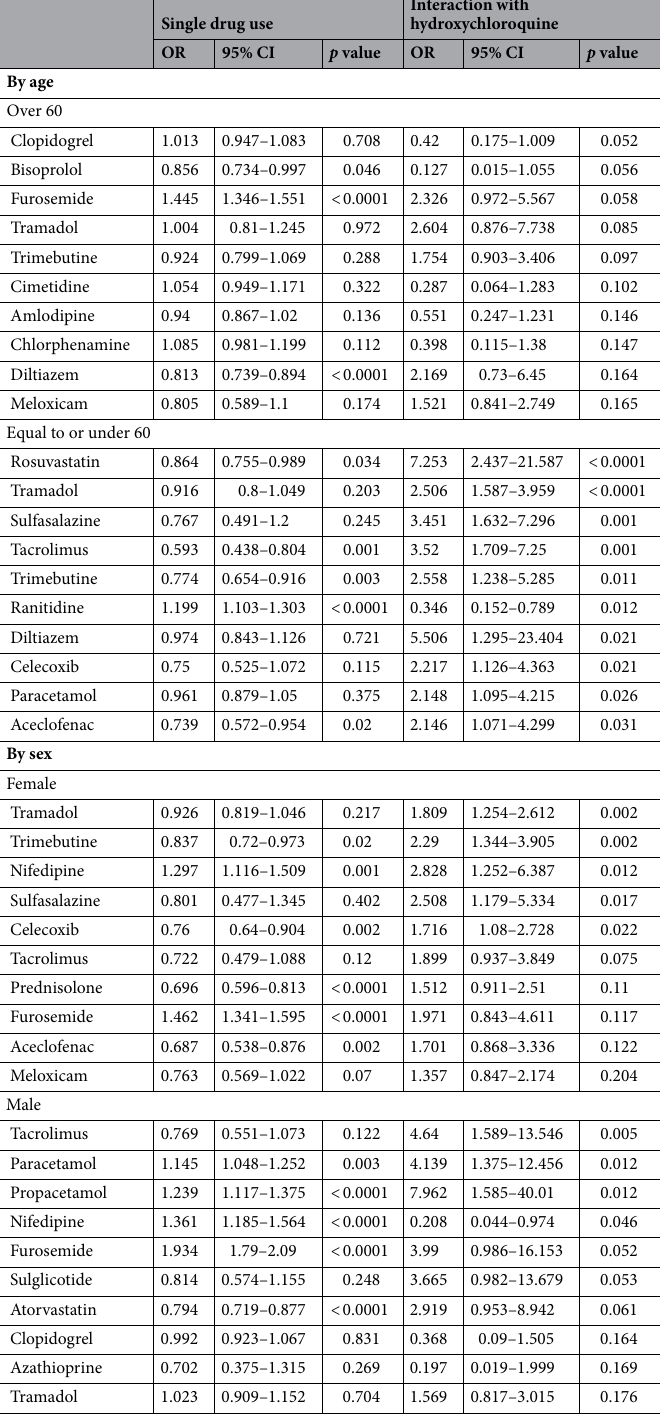
Table 3. Ten drugs with the lowest p value of interaction terms for each subgroup. This table shows the ten drugs with the lowest p value of the interaction term with hydroxychloroquine in each subgroup. Each subgroup was divided into over 60 years old and under 60 years old or divided into male and female. ‘Single drug use’ columns show the odds ratio (OR), 95% confidence interval (95% CI), and p value of the analyzed drug in the linear regression, and ‘Interaction with hydroxychloroquine’ columns show OR, 95% CI, and the p value of the interaction term with hydroxychloroquine. p value was calculated through the two-sided T